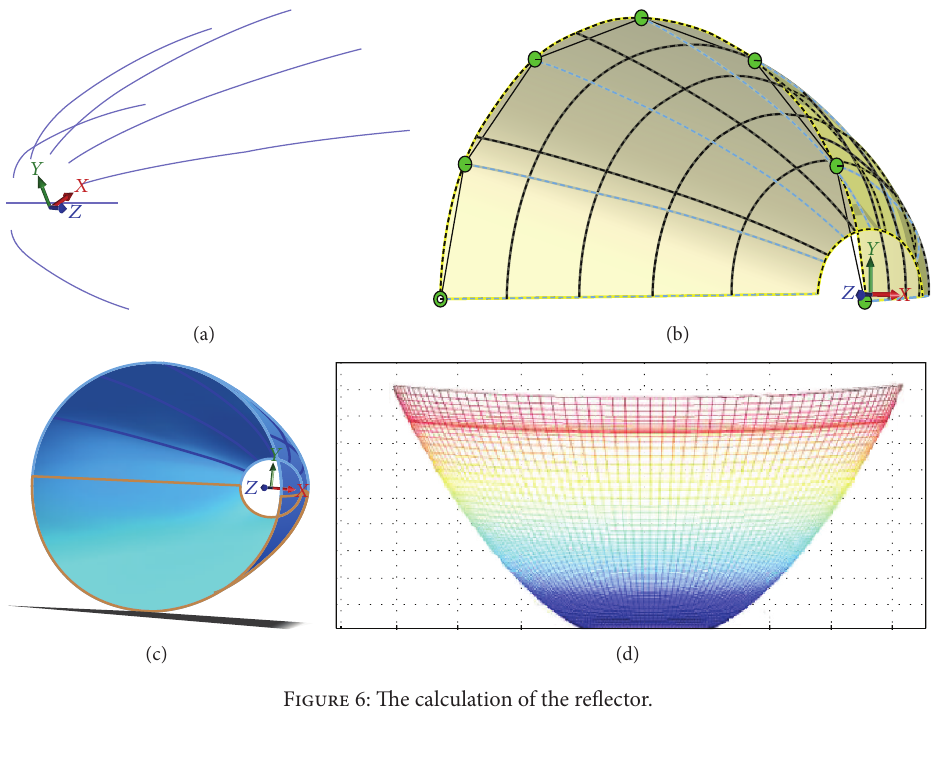
Figure 6: The calculation of the reflector.